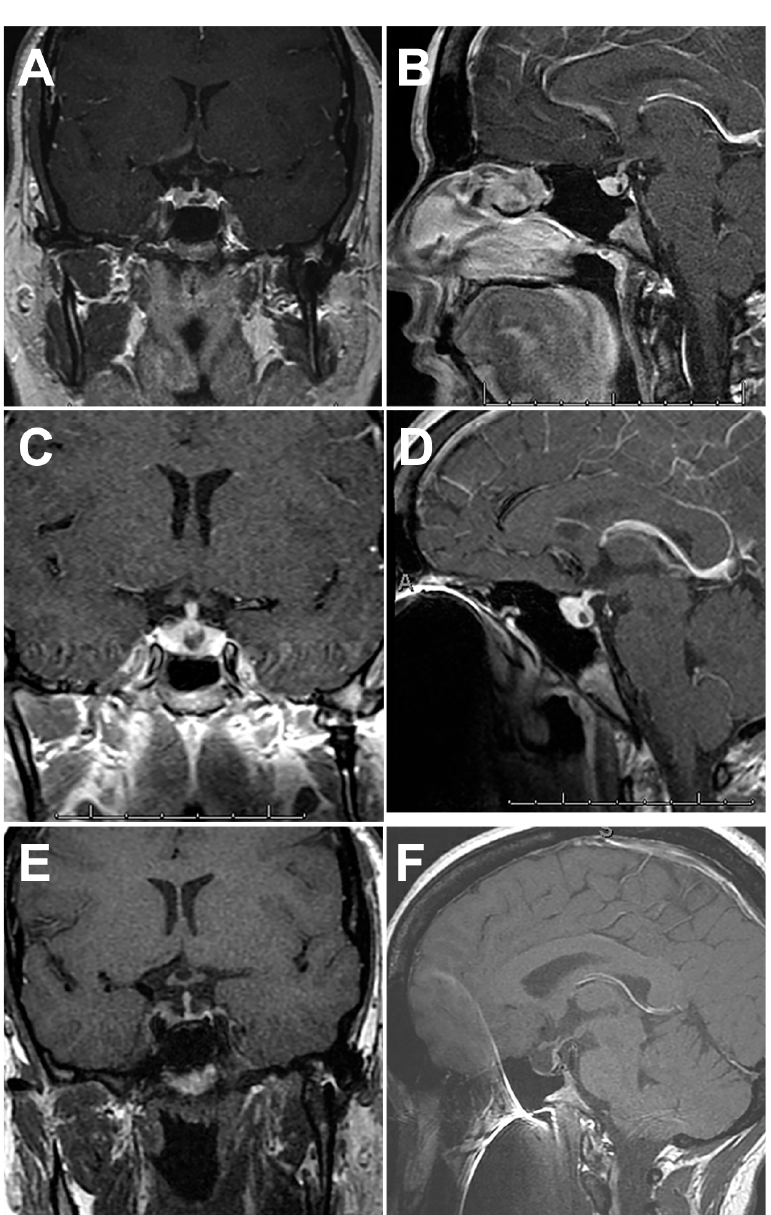
Figure 1. This 34-year-old woman presented with a 2-year history of galactorrhea and hyperpro- lactinemia, treated successfully with cabergoline. During previous treatment for Crohn disease, gadolinium-enhanced MRI showed a normal-appearing pituitary gland with Rathke cleft cyst (RCC) in the intermediate lobe (( A ), axial; ( B ), sagittal). At 2-year follow-up, she had progressive headaches and her menstrual periods had ceased. MRI demonstrated the RCC and definite enlargement of the pituitary (( C ), axial; ( D ), sagittal). No definitive adenoma was identifiable. Endocrine labs demonstrated normal prolactin, low gonadotroph and estrogen levels (central hypogonadism), and low normal thyroid hormone (all consistent with partial hypopituitarism). She underwent pituitary biopsy and drainage of the RCC. Pathological evaluation demonstrated ciliated low cuboidal epithe- lium and surrounding chronic lymphocytic inflammation. The anterior pituitary gland had marked mononuclear inflammation. The diagnosis was non-necrotizing granulomatous hypophysitis. She was treated with 40 mg/0.8 mL adalimumab weekly. Her headaches resolved but she developed progressive panhypopituitarism requiring replacement therapy. MRI demonstrated progressive pituitary atrophy 2 years later (( E ), axial; ( F ),